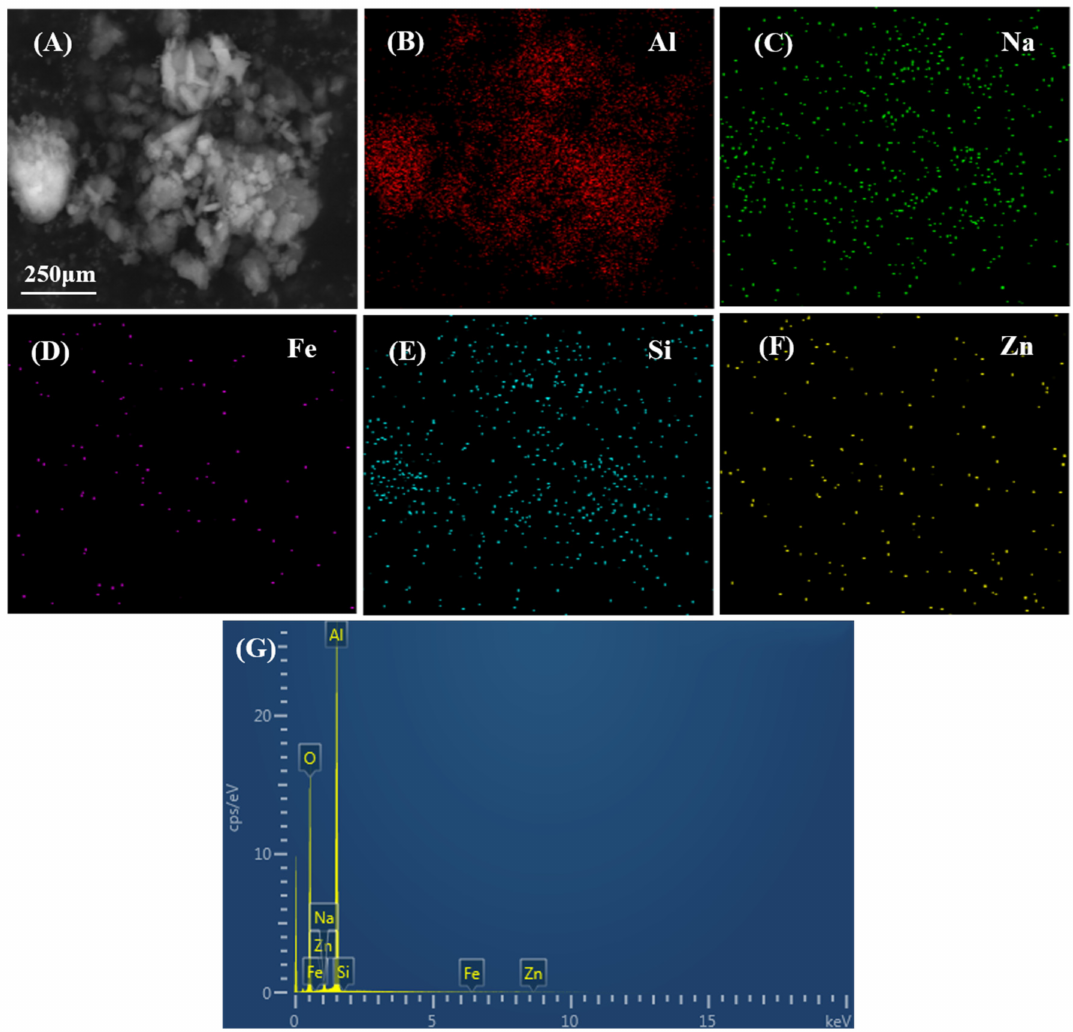
Figure 5. ( A ) SEM image; ( B – F ) element mapping images of Al, Na, Fe, Si, and Zn; ( G ) EDS spectra of element mapping